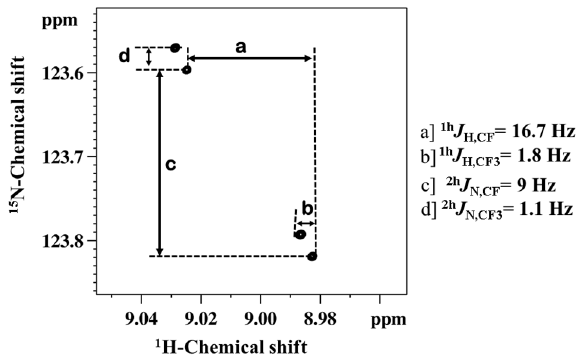
Figure 9. 400 MHz two-dimensional 15 N- 1 H-HSQC spectrum of molecule 5 in the CDCl 3 , depicting the through-space couplings. The measured coupling strengths are identified by a − d and their values have also been reported.